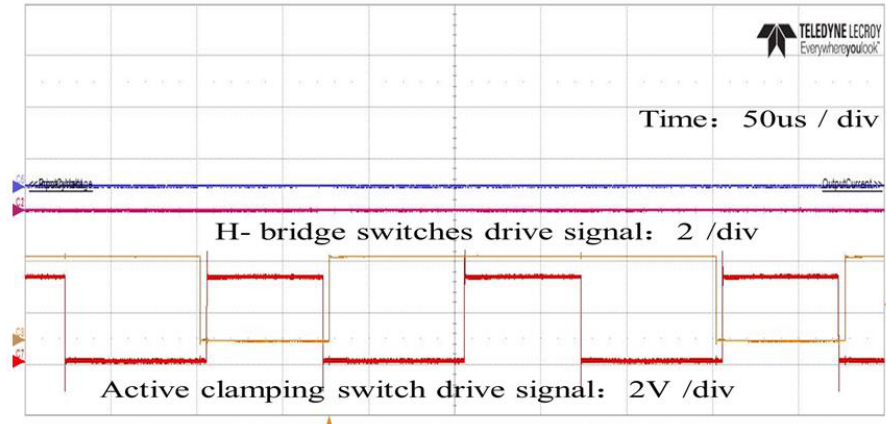
Figure 14. Drive signals of active clamping and H-bridge switches.